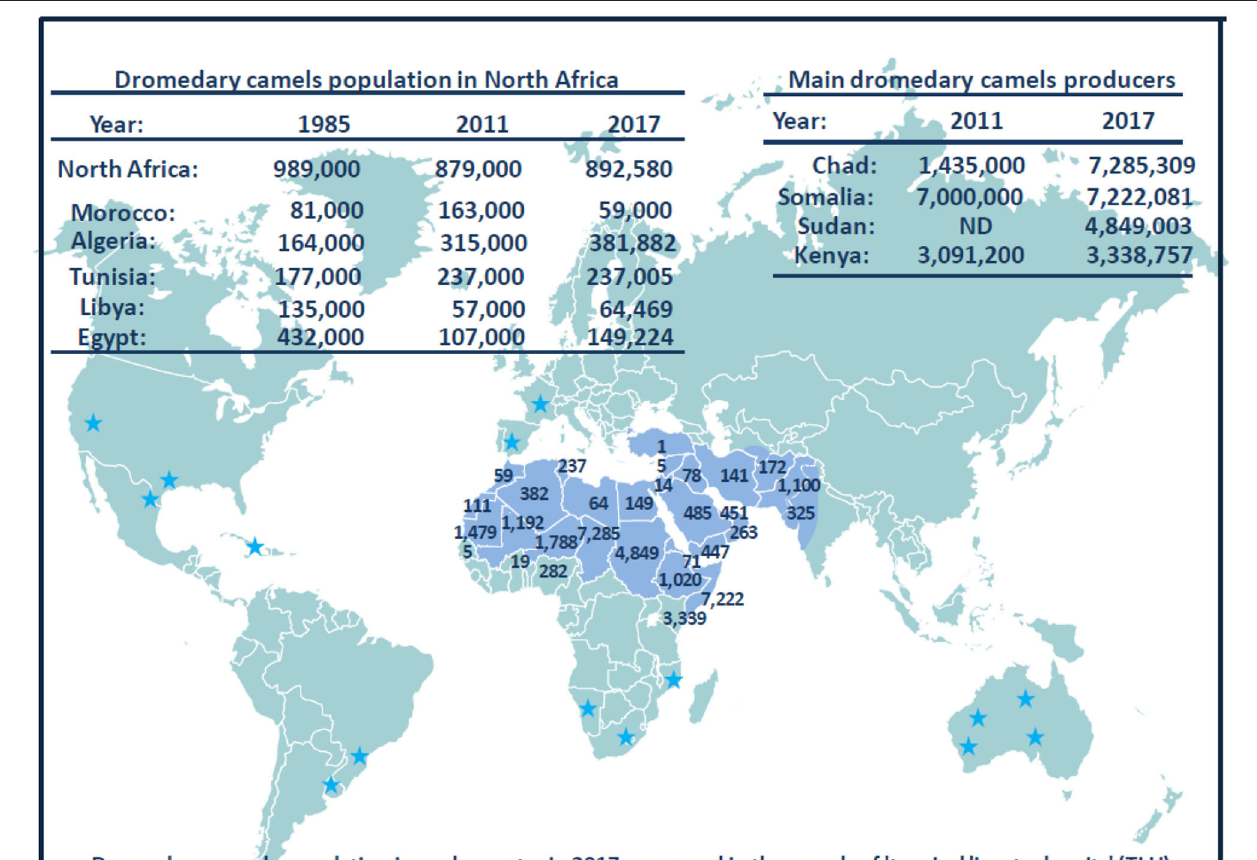
FIGURE 6 | Schematic representation of dromedary camel distribution in the world. The Arabic generic term commonly used for camel is “ibl.” Male camel between 6 and 20 years old are named “jamal” (also the Arabic word for beauty ). Currently, there are ∼ 33 million dromedary camels (or humpback camels) worldwide, with highest numbers (77%) in Africa and the Middle East. The geographical location of the dromedary is in the belt of the tropical and subtropical dry zones of Africa, but its presence extends to Western Asia and Northwest India (blue area on the map). Dromedary camels are found in 35 native countries ranging from Senegal to India and from Kenya to Turkey. The number on the map show the population of dromedary camels in each country in 2017 expressed in thousands of “tropical livestock units” (TLUs), according to FAO ( 369). For example, the largest dromedary camel populations are found in Chad (7,285,309 camel heads) and Somalia (7,222,081 camel heads), followed by Sudan (4,849,003 camel heads) and Kenya (3,338,757 camel heads). Regarding the countries of the Southern coast of the Mediterranean Sea, the current livestock situation is as follows: 59,000 camels for Morocco; 381,882 camels for Algeria; 237,005 camels for Tunisia; 64,469 camels for